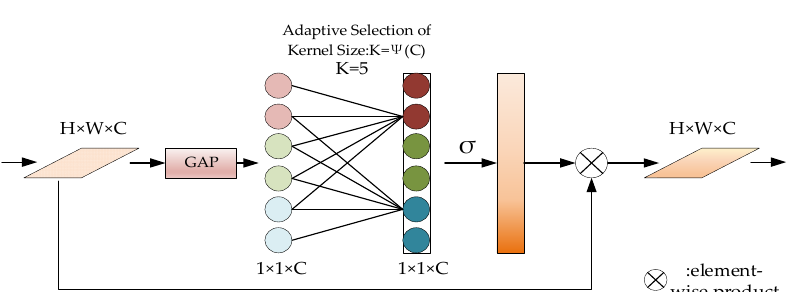
Figure 4. SENet network structure.